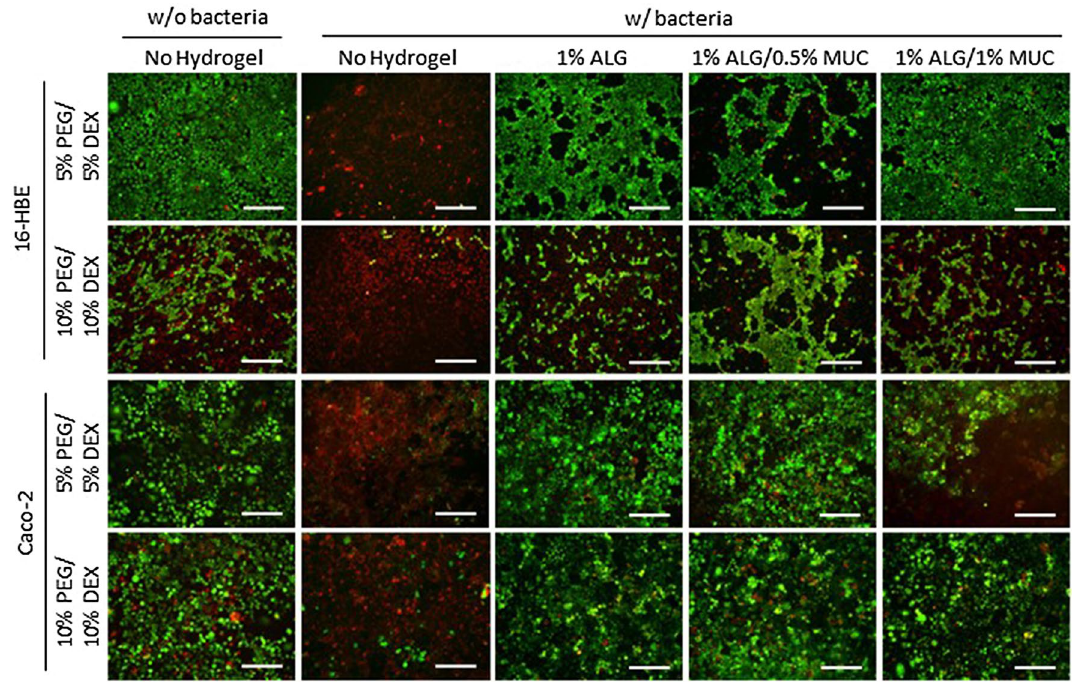
Figure 4. Live/Dead staining images of 16-HBE and Caco-2 cells after a 19-h (with ciprofloxacin supplemented PEG-phase added after 7 h) co-culture with P. aeruginosa and S. flexneri , respectively, deposited with a PEG- DEX ATPS either with or without an alginate-based hydrogel between mammalian cells and ATPS. Bacteria were deposited using a 5% PEG/5% DEX ATPS or 10% PEG/10% DEX ATPS over mammalian cells with an alginate-based hydrogel (1% ALG, 1% ALG/0.5% MUC, and 1% ALG/1% MUC) overlay, where a DEX droplet with or without bacteria was deposited directly onto mammalian cells as controls (scale bar = 500